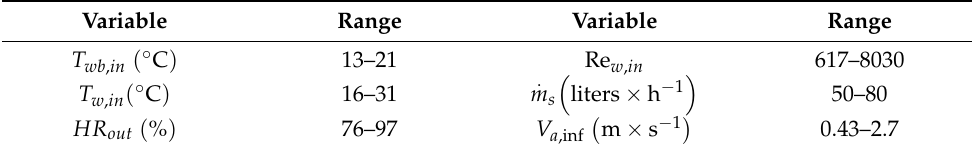
Table 3. Experimental range of the main variables involved.